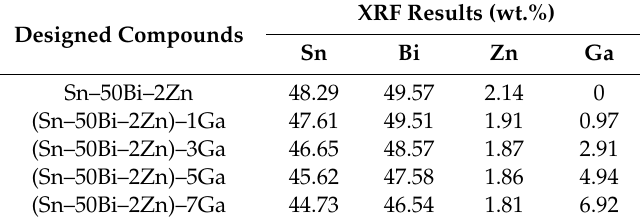
Table 1. The compositions of the alloys measured by X–ray fluorescence (XRF). Designed